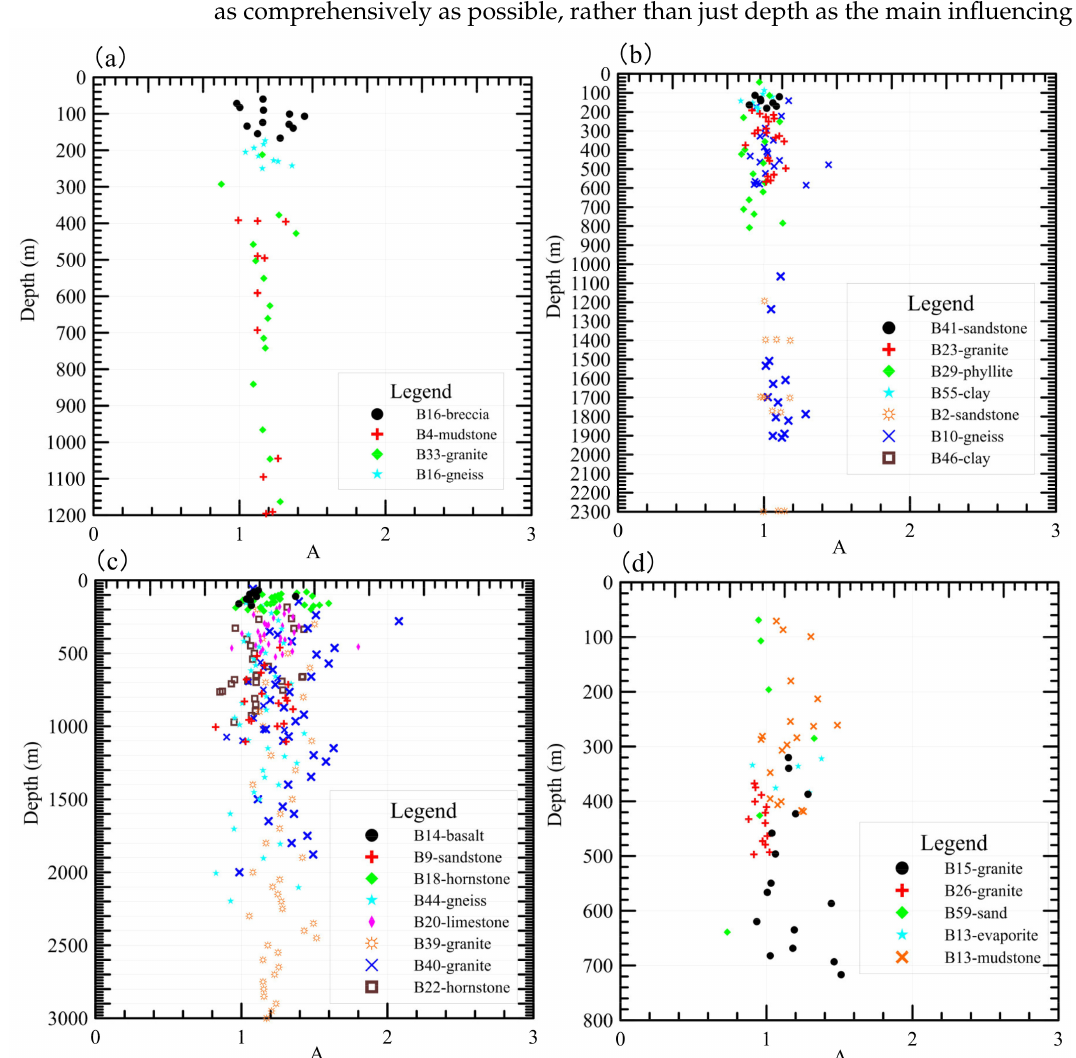
Figure 5. Relationship between the anisotropic factor of thermal conductivity and depth: ( a ) examples of increasing anisotropic factor of thermal conductivity with depth; ( b ) examples of little variation in the anisotropic factor of thermal conductivity with depth; ( c ) examples of decreasing anisotropic factor of thermal conductivity with depth; ( d ) examples of irregular fluctuations in the anisotropic factor of thermal conductivity with